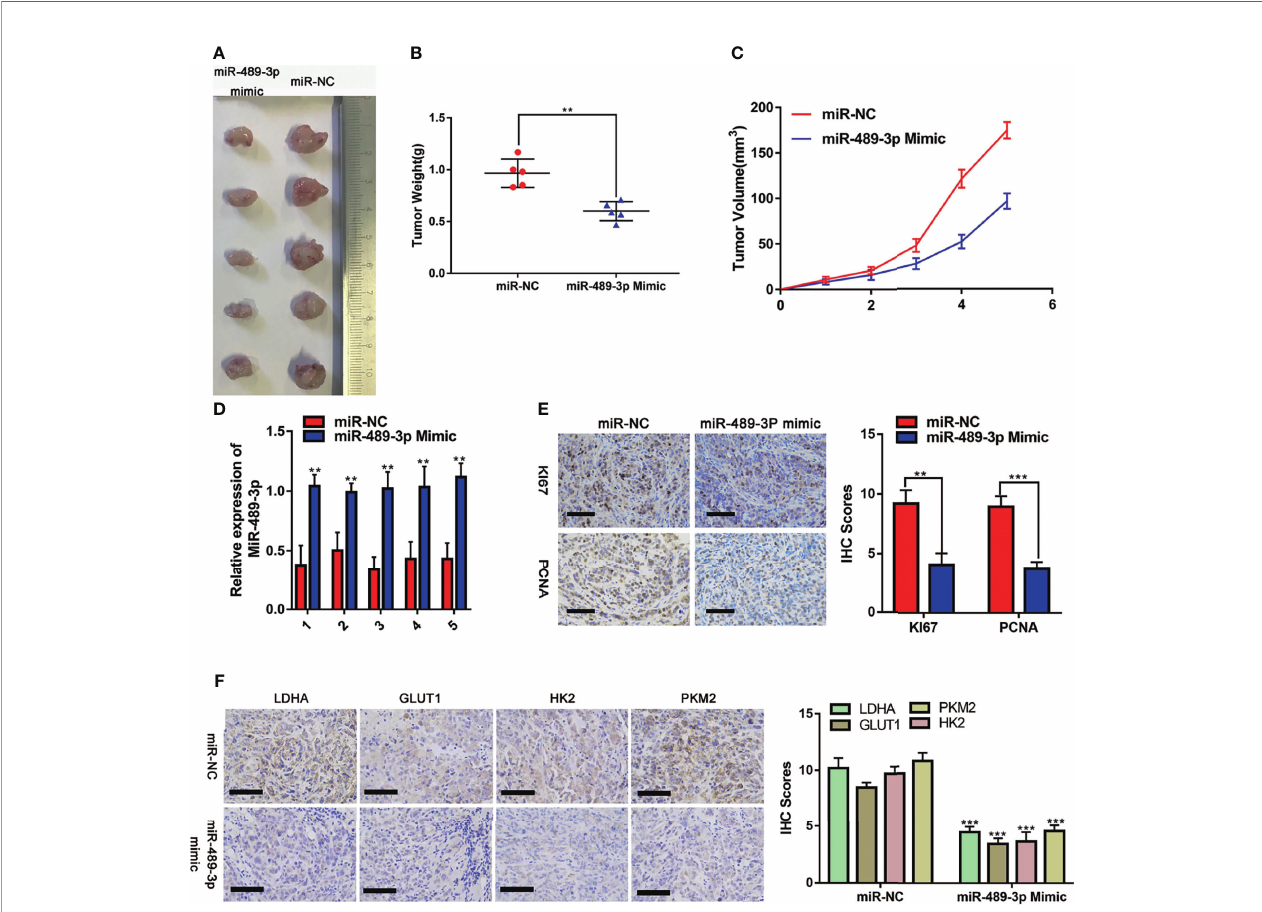
FIGURE 7 | Effects of overexpression of miR-489-3P on PC proliferation and metabolism in vivo . (A) Typical images of nude mice tumors (n = 5), (B) subcutaneous tumor weight, (C) subcutaneous tumor volume, (D) miR-489-3p expression in xenografts by qRT-PCR. (E) Typical IHC staining images of xenografts show Ki-67 and PCNA expression. The bar stands for 50 microns. (F) Typical IHC staining images of xenografts show the expression of metabolic indicators (LDHA, GLUT1, HK2, PKM2). The bar stands for 100 microns. (**P < 0.01, ***P <